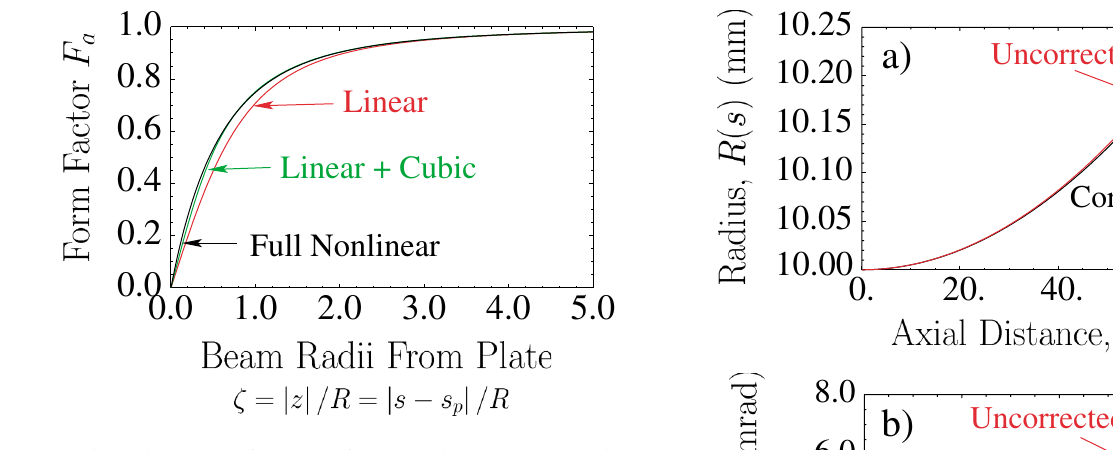
Initial and final envelope radii and angles for an axisymmetric beam free drifting from s (cid:1) 0 into a conducting plate (cid:1) 70 mm . Envelope solutions are produced by numerical integration of Eq. (20) with various form factor models for F at s (cid:1) s p and self-consistent 3D PIC simulations are produced with the WARP code. Final envelope radii and angles are tabulated for (cid:1) 1 , linear corrected envelope model F uncorrected envelope model with F a or (19)], and PIC simulations.